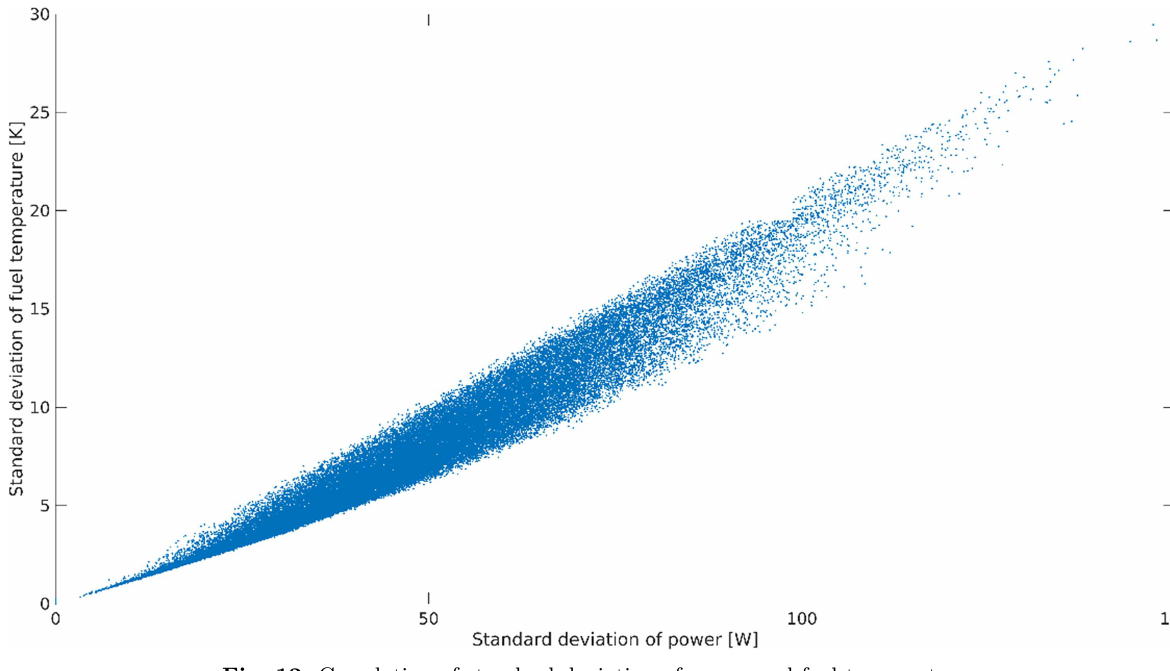
Fig. 12. Correlation of standard deviation of power and fuel temperature.